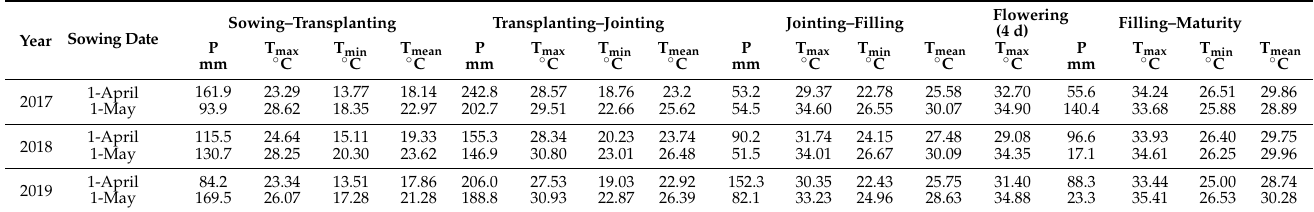
Table 2. Meteorological data of two sowing dates in 2017–2019.